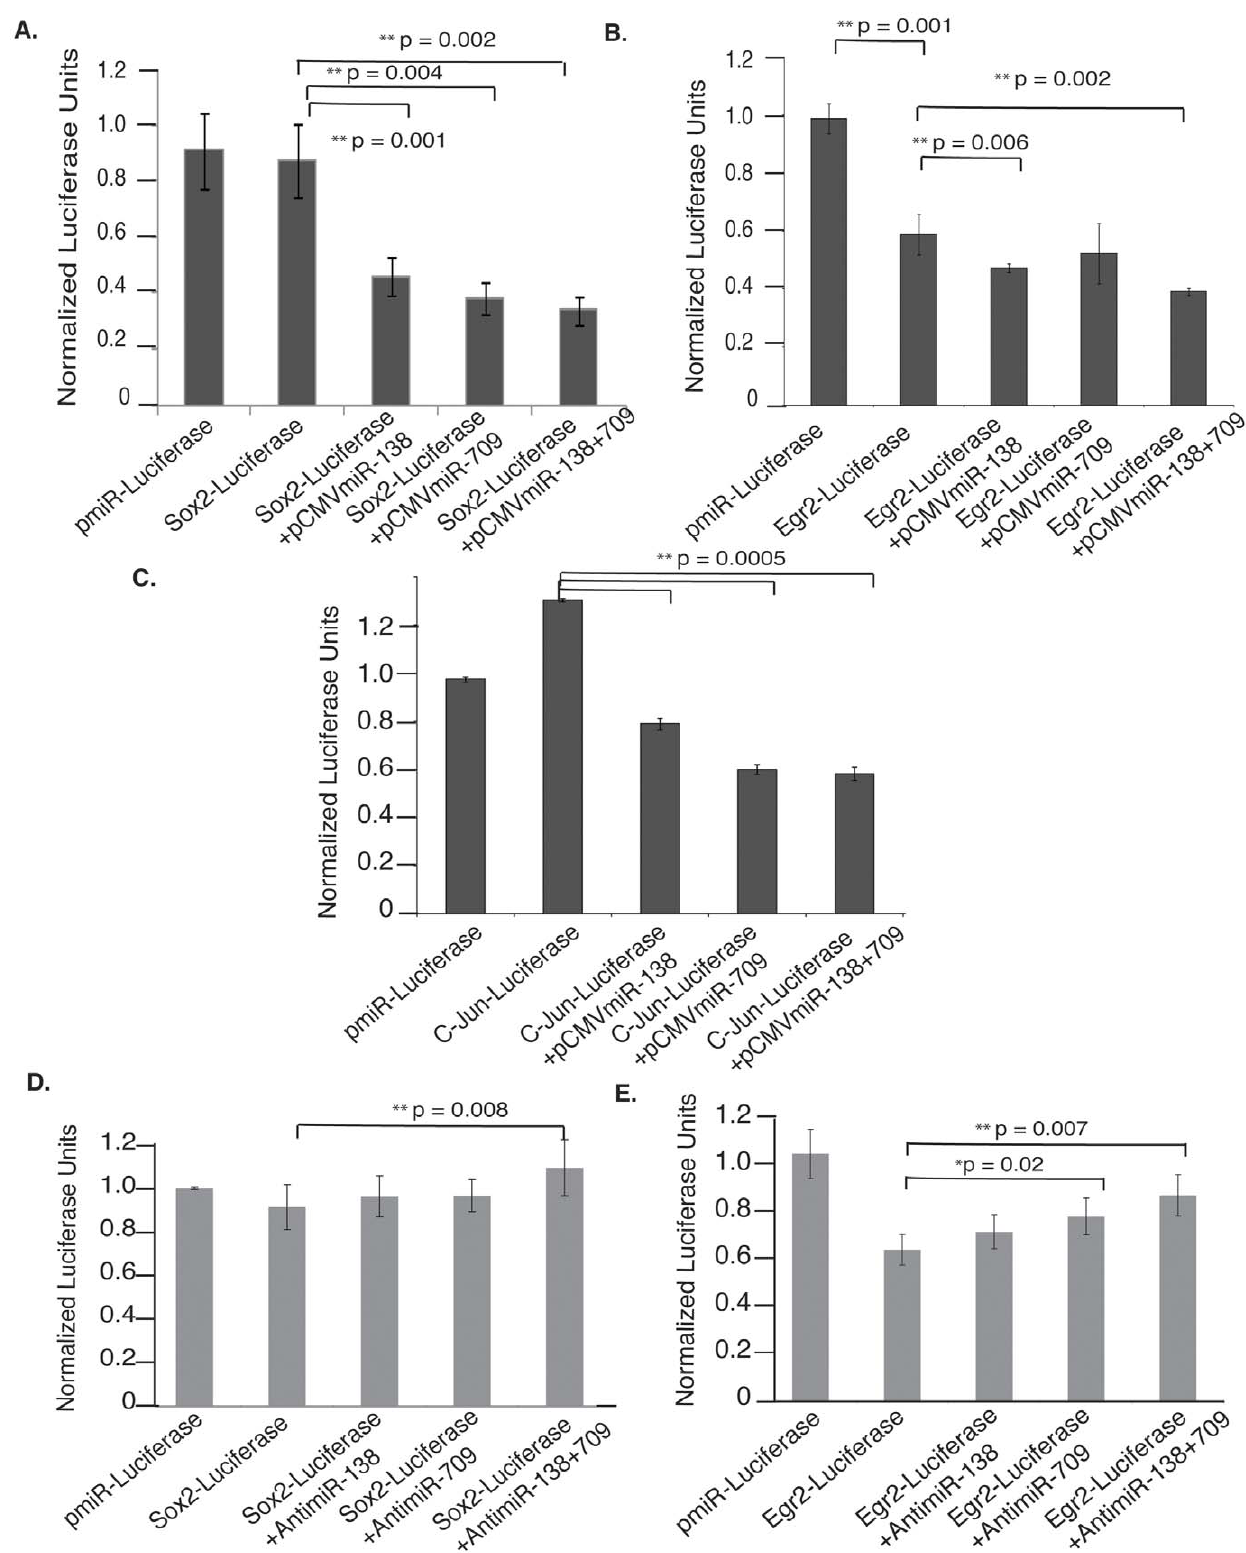
Figure 3. miR-138 and miR-709 bind and regulate Sox-2, c-Jun and Egr2. Sox-2, c-Jun and Egr2 transcripts containing multiple target sites for both miRNAs 138 and 709 were cloned into the 3 9 -UTR of luciferase gene in the pmiR-report vector. Cos-7 cells were co-transfected with miR- target vector and pmir-Report b -Gal vector as a control for transfection efficiency. Cell lysates were assayed 24 h post transfection for luciferase and b -Gal expression and b -Gal is used to normalize for differences in transfection efficiency. Sox-2, which lacks highly accessible sites for miR-138 and miR-709 show comparable expression to control (A & D, first two bars), while c-Jun (C, first two bars) and Egr2 (B & E, first two bars) that have multiple